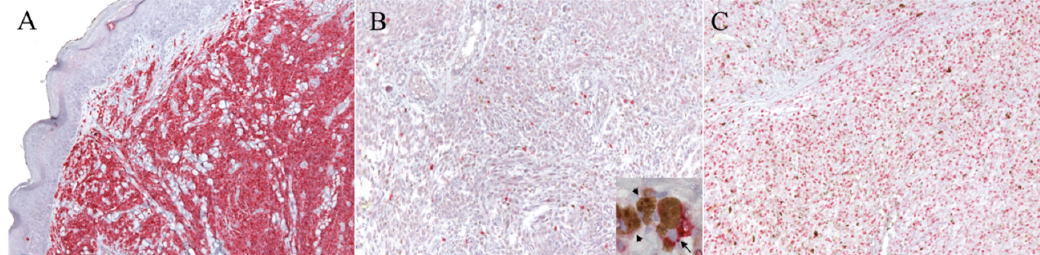
Figure 1. IHC for KIT and Ki67 with the RED labeling system. ( A ) Mast cell tumor (MCT). Example of the mast cell tumor used as the control tissue for the KIT immunolabeling, with a high density of positive cells (100× magnification). ( B , C ) Canine oral melanoma (COM). ( B ) Example of a neoplastic area selected for the evaluation of the KIT index, which was 6.6 (100× magnification): the positive cells are discernible and scattered throughout the field. The details of the positive neoplastic melanocytes (arrow) are provided with higher magnification in the inset; melanomacrophages are also present within the inset (arrowheads). ( C ) Example of a neoplastic area selected for the evaluation of the Ki67 index, which was 30 (100× magnification).